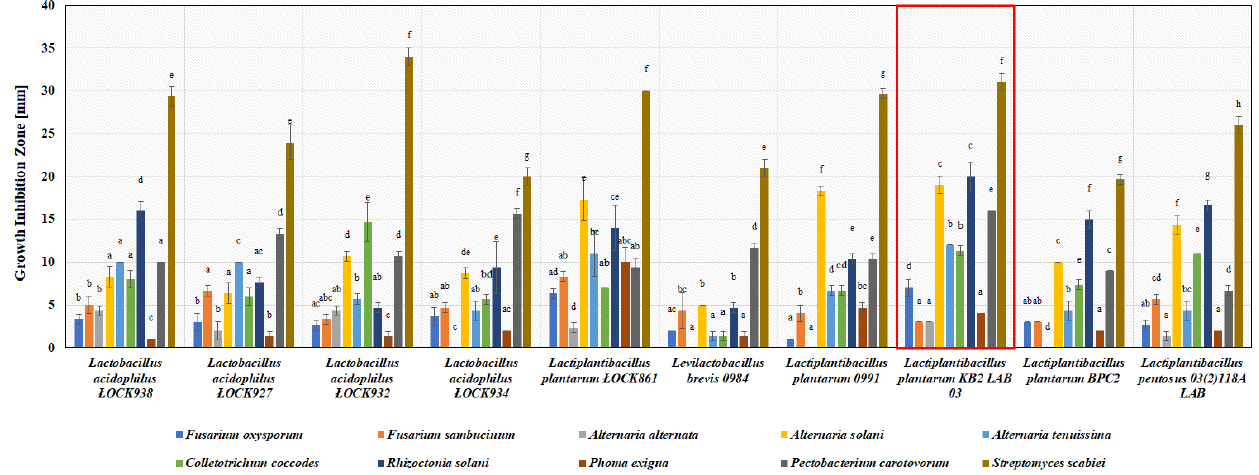
Figure 1. Antimicrobial activity of selected ten most active lactic acid bacteria strains cultivated on MRS medium (about 10 8 CFU/mL) against potato phytopathogens after 2–5 days of incubation (depending on the pathogen), measured as growth inhibition zones in the agar-plug diffusion method. a–h—results with different letters within the sample are significantly different (Tukey’s test, α = 0.05).